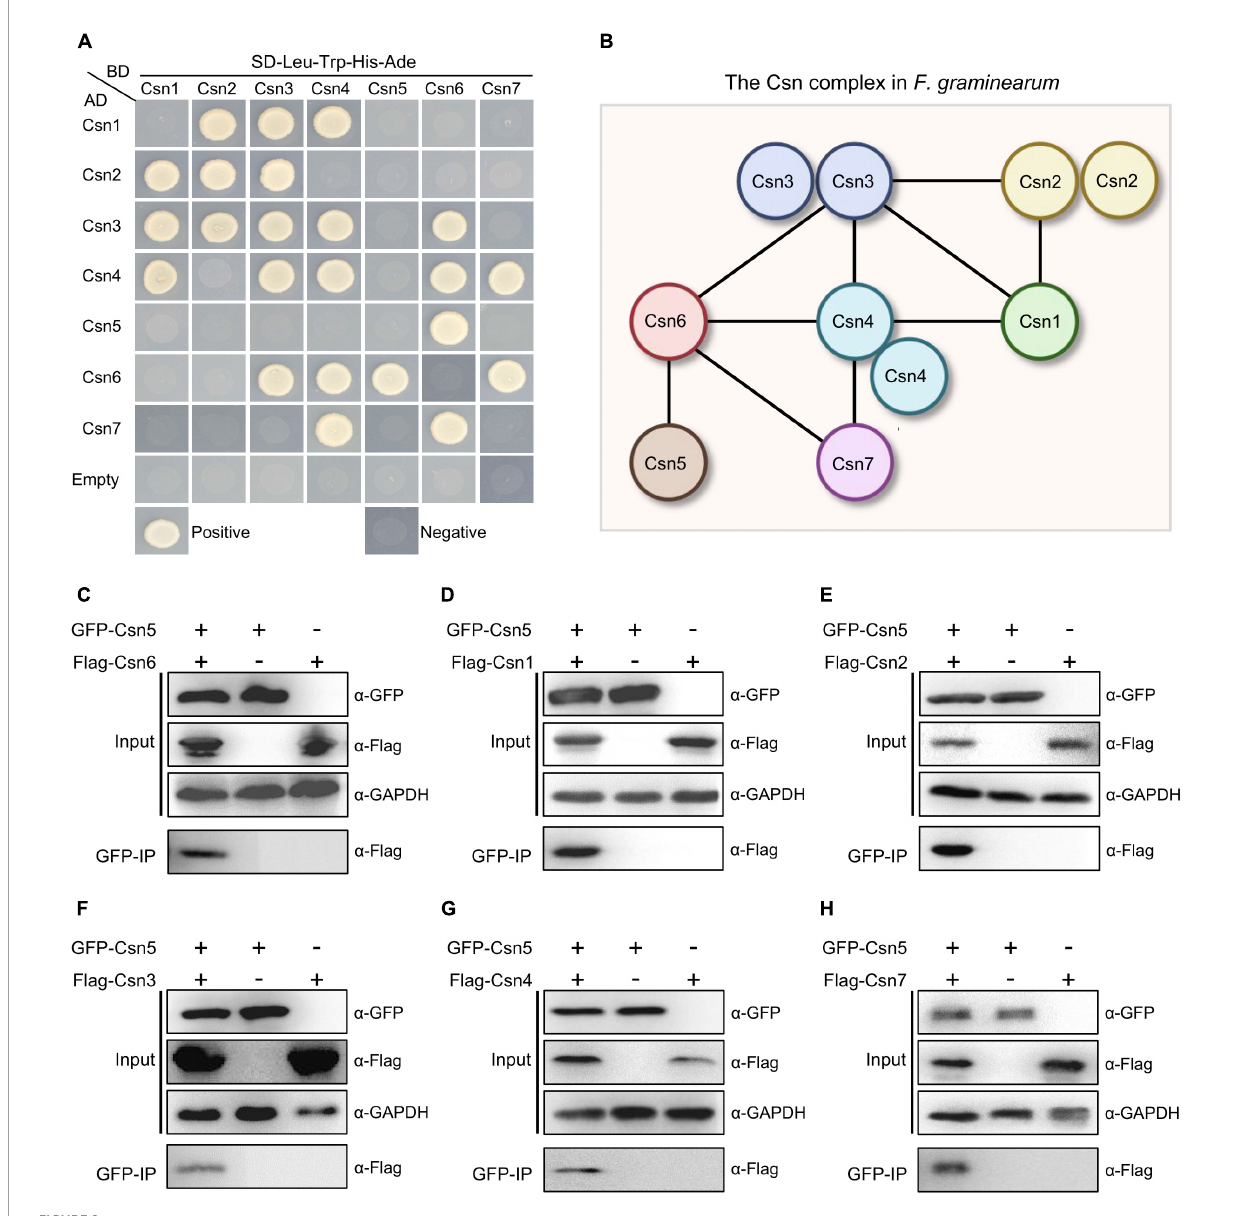
FIGURE2 Protein–protein interactome of the Csn complex in F. graminearum . (A) Interactions between the Csn subunits. The interactions of pGBKT7-53/pGADT7-T and pGBKT7-Lam/pGADT7-T were used as positive and negative controls, respectively. Yeast transformants carrying the indicated constructs were plated onto selective plates supplemented without Leu/Trp/His/Ade to assay growth. (B) A model depicting the protein–protein interactions among the Csn subunits of the Csn complex. The black lines indicate the direct interaction. (C) Western blot showing the interaction between Csn5 and Csn6 by using a coimmunoprecipitation (co-IP) assay. Total proteins isolated from the strains bearing GFP-Csn5 and/or Flag-Csn6 (input) and the proteins eluted from the anti-GFP beads (elution) were detected using anti-Flag antibody. GAPDH was used as an internal control. (D) Western blot showing the interaction between Csn5 and Csn1 by using a co-IP assay. (E) Western blot showing the interaction between Csn5 and Csn2 by using a co-IP assay. (F) Western blot showing the interaction between Csn5 and Csn3 by using a co-IP assay. (G) Western blot showing the interaction between Csn5 and Csn4 by using a co-IP assay. (H) Western blot showing the interaction between Csn5 and Csn7 by using a co-IP